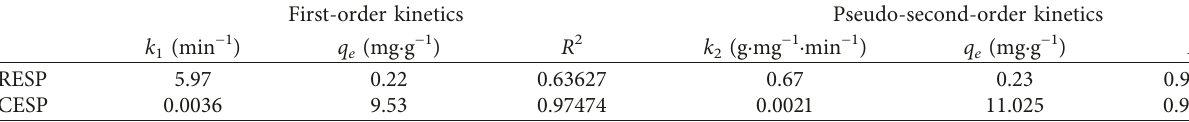
Table 1: Summary of kinetic studies for MB